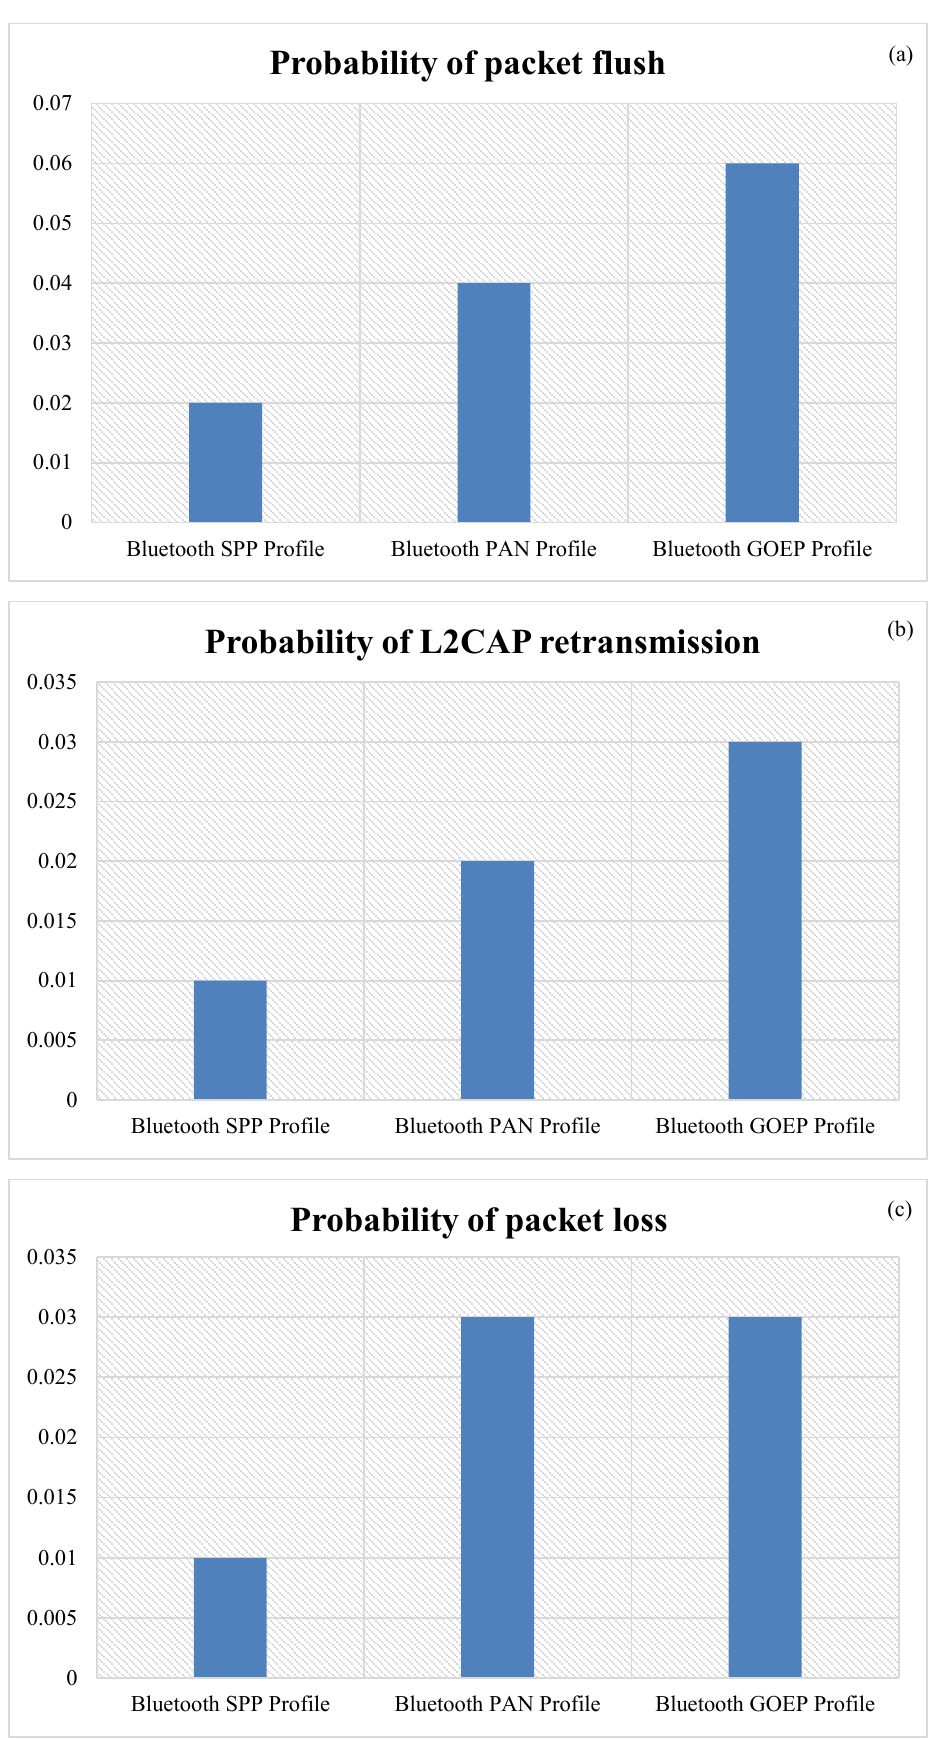
Figure 10. (a) Probability of packet flush results, (b) Probability of L2CAP retransmission results, and (c) Probability of packet loss results of the Bluetooth SPP, Bluetooth PAN and the Bluetooth GOEP